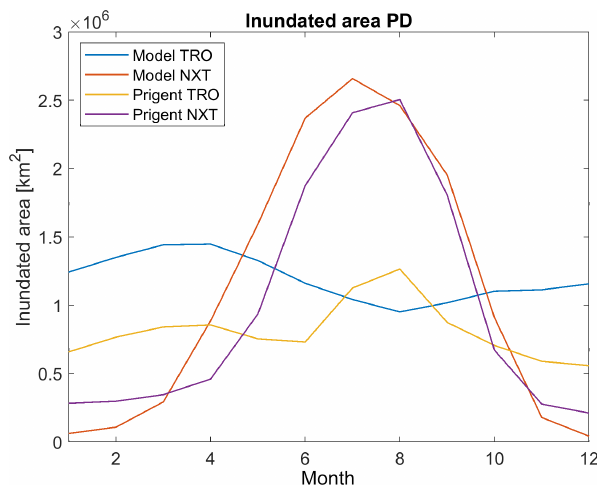
Figure 2. Climatology of monthly-mean inundated area for model years 2000–2009 and Prigent et al. (2012) observations (1993– 2007), which is separated for the tropics (TRO) and NH extratropics